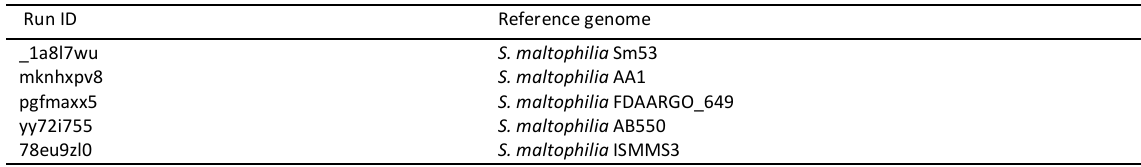
Table 1 - RAREFAN IDs linking to the raw data of the presented